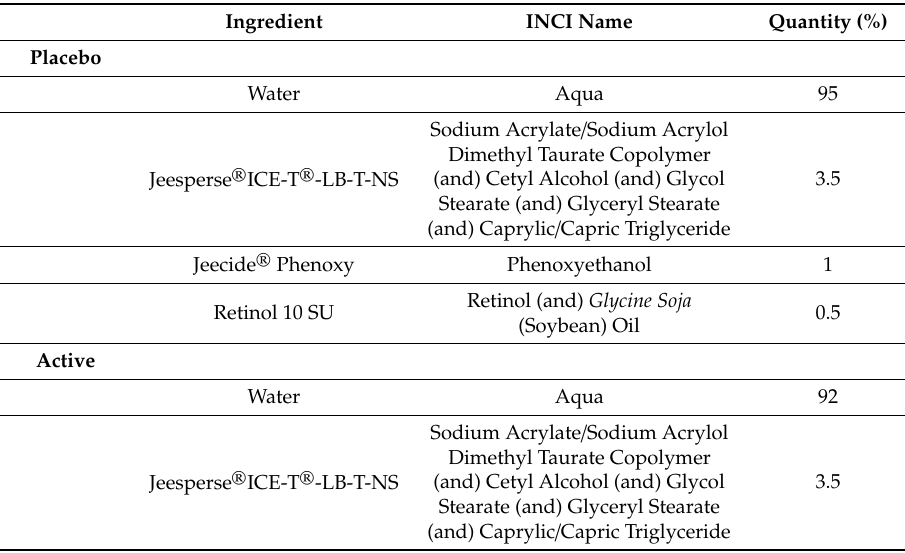
Table 1. Ingredients employed in formulations used in the